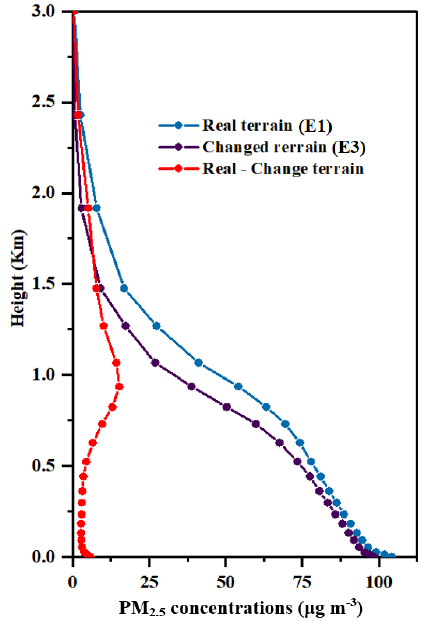
Figure 5. Vertical distribution of the averaged PM 2.5 levels in real terrain (E1; blue dotted line) and changed terrain (E3; purple dotted line) simulations and their difference (red dotted line).